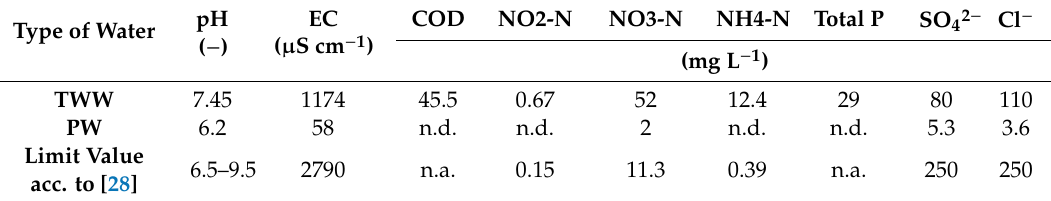
Table 4. Quality of the used treated waste water (TWW) and precipitation water (PW), n.d. not detectable, n.a. not